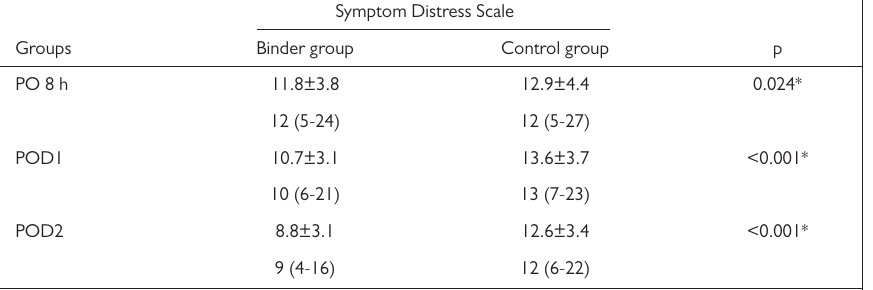
Table 4. Symptom Distress Scale of the study and control groups